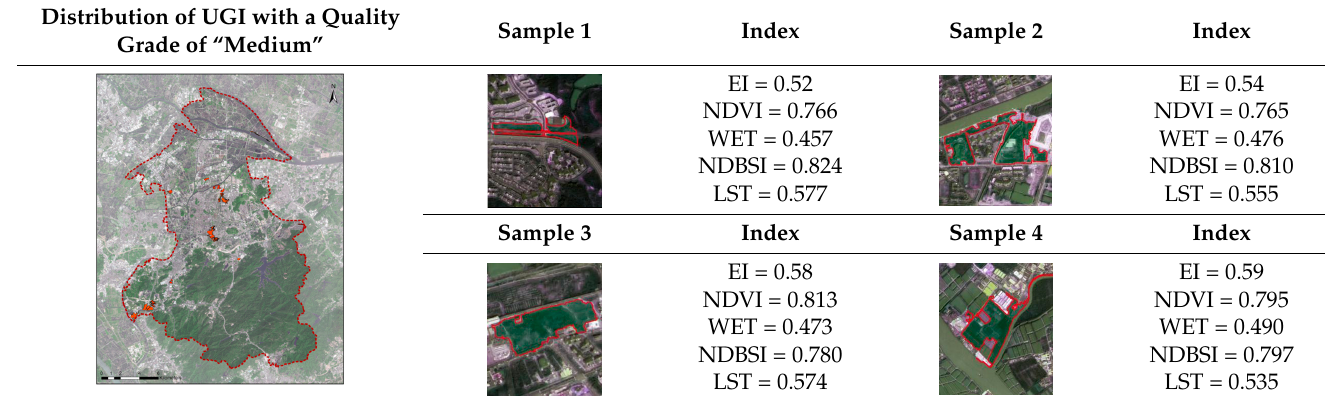
Table 10. Distribution and typical samples of UGI with a quality grade of “medium”.